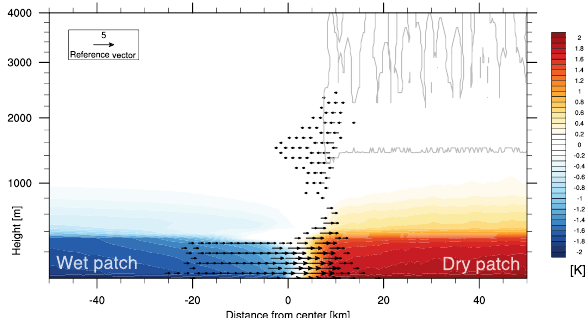
Figure 3. x – z diagram at 12:00LST of y -averaged quantities for the DA_20_100 case. Zonal temperature anomaly (color contours), zonal wind (vectors, values between − 0.5 and 1ms − 1 are masked) and cloud water mixing ratio (grey contour, only 10 − 5 gkg − 1 iso- line). On the x -axis, numbers indicate the distance from the center of the domain in